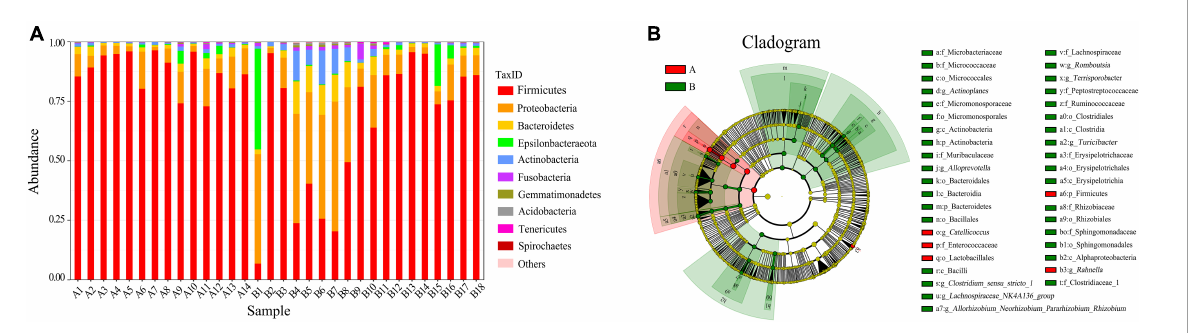
FIGURE2 (A) Relative abundance bar plot of the relative abundance of the strains. Relative abundance (%) of the two cranes Top10 phyla. Red-crowned crane, A1–A14; white-naped crane, B1–B18. (B) Annotated branching diagram of differential strains. Red nodes indicate species with relatively high abundance in the red group, green nodes indicate species with relatively high abundance in the green group, yellow nodes indicate species with no significant difference in the comparison between the two groups, the node diameter size is proportional to the relative abundance size, each layer of nodes indicates the phylum/class/order/family/genus from the inside out. (A) Red-crowned crane, (B) white-naped